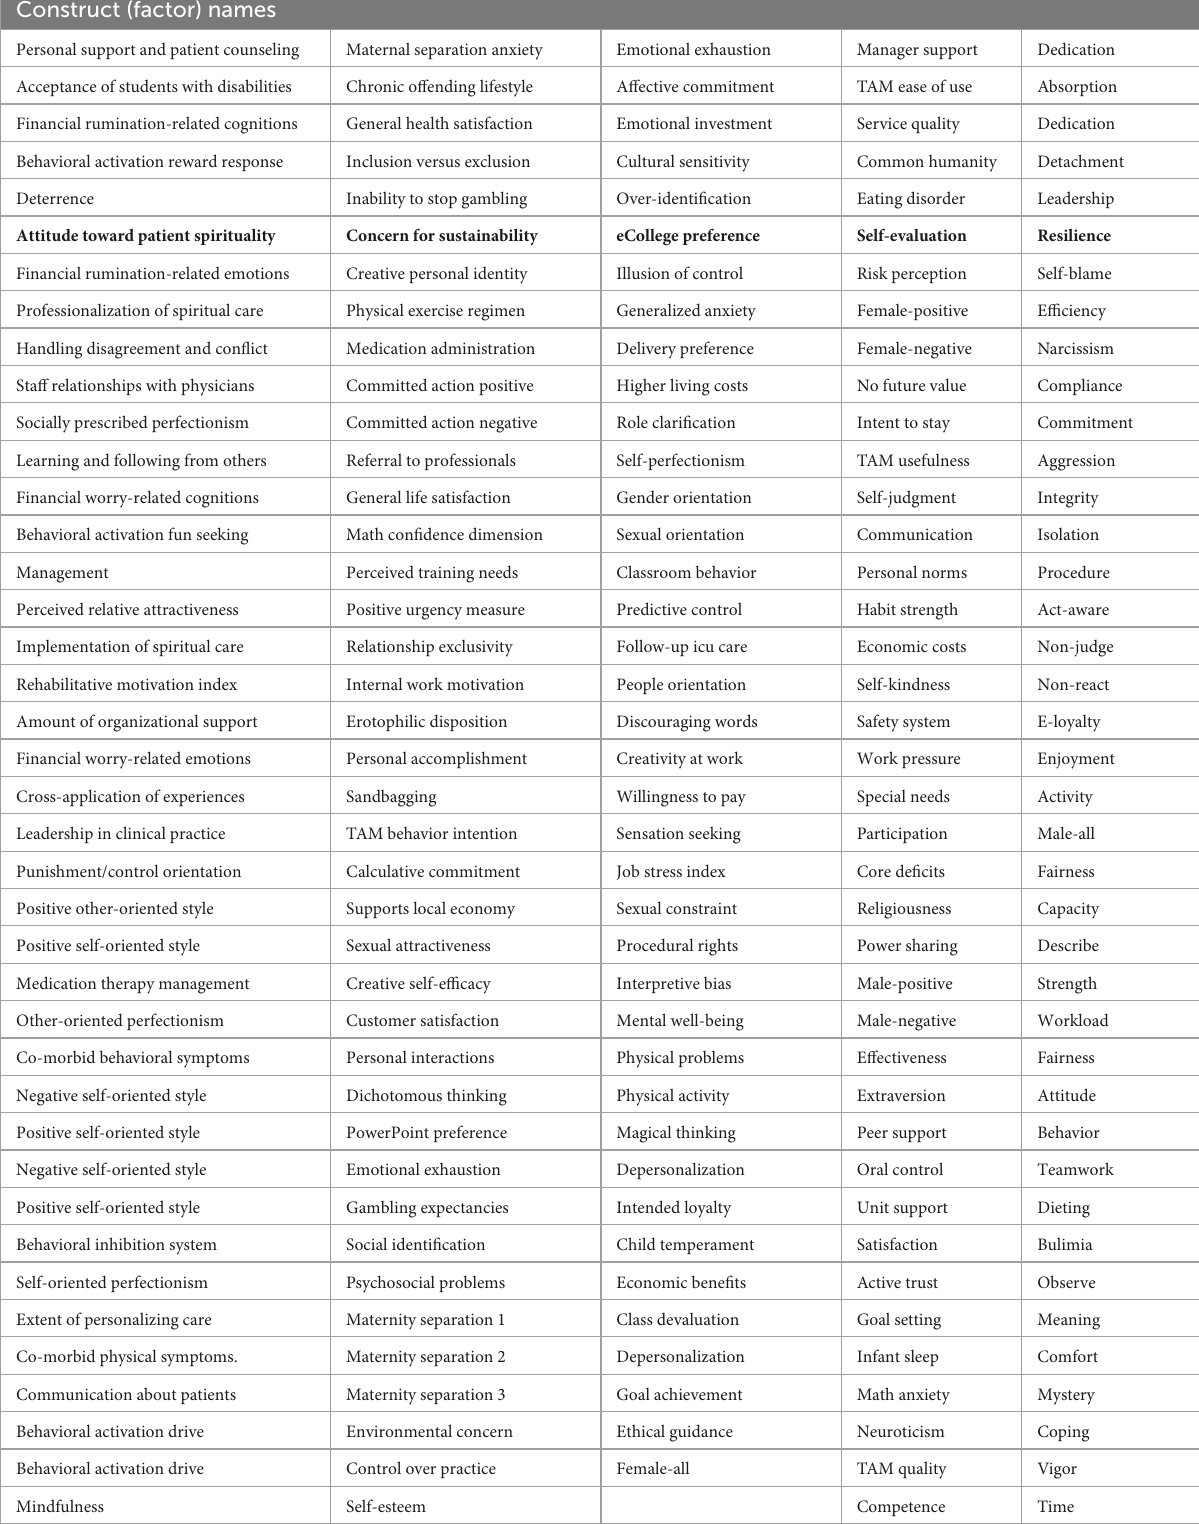
TABLE 4 Constructs included in the semantic factor